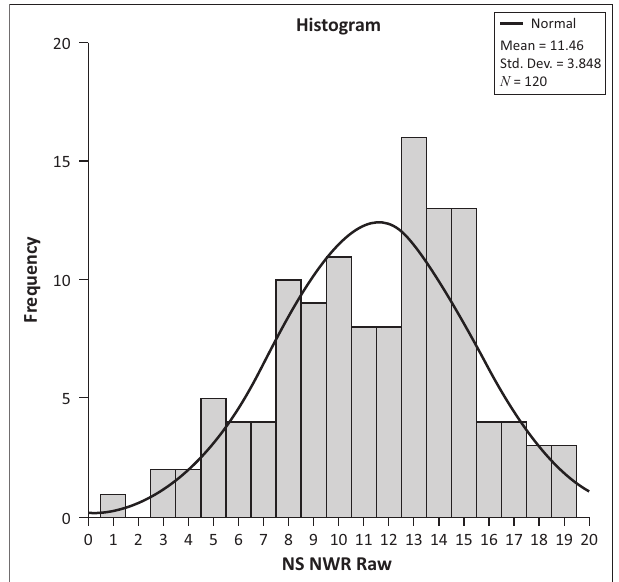
FIGURE 2: Distribution of NS NRT scores in the tested